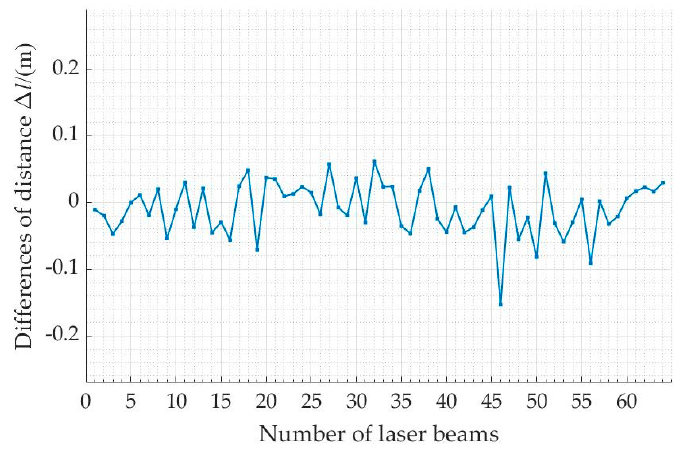
Figure 15. Differences in measured distance ∆ l i .